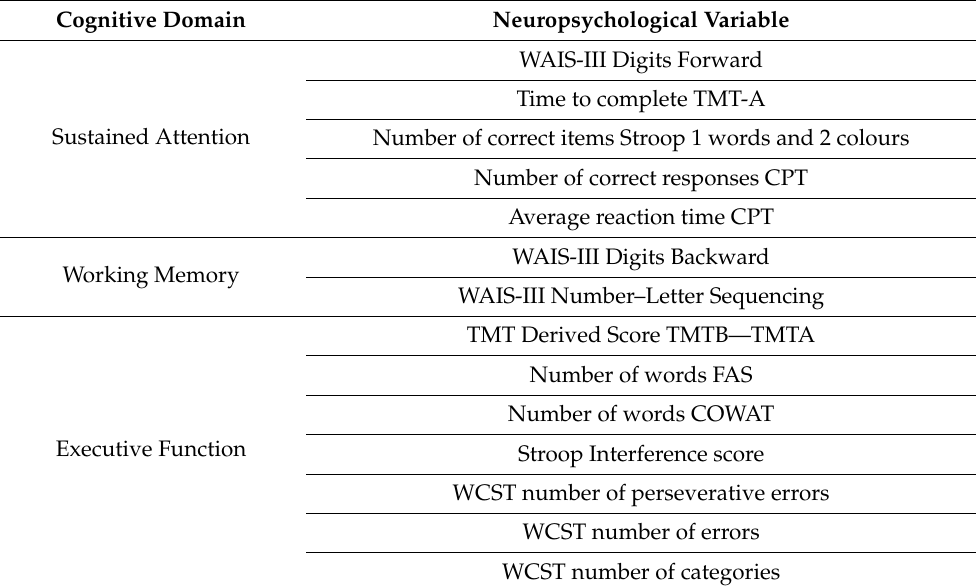
Table 1. Neuropsychological test and variables used to evaluate cognitive function performance at baseline and at two year